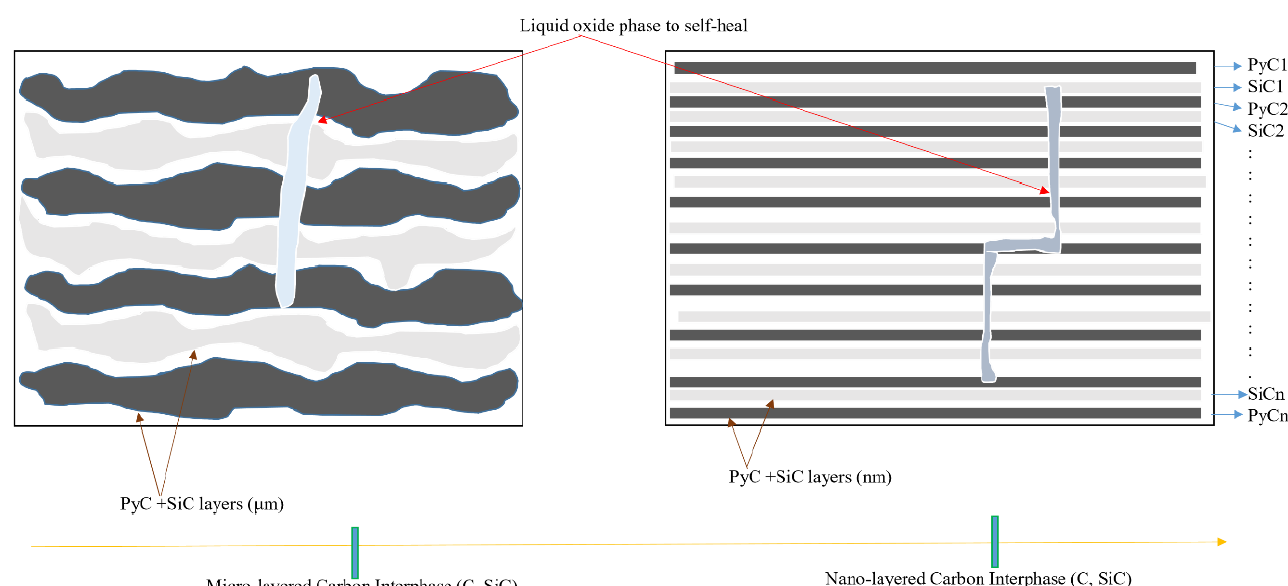
Figure 12. Interphase thickness between nano-carbon layers [157].